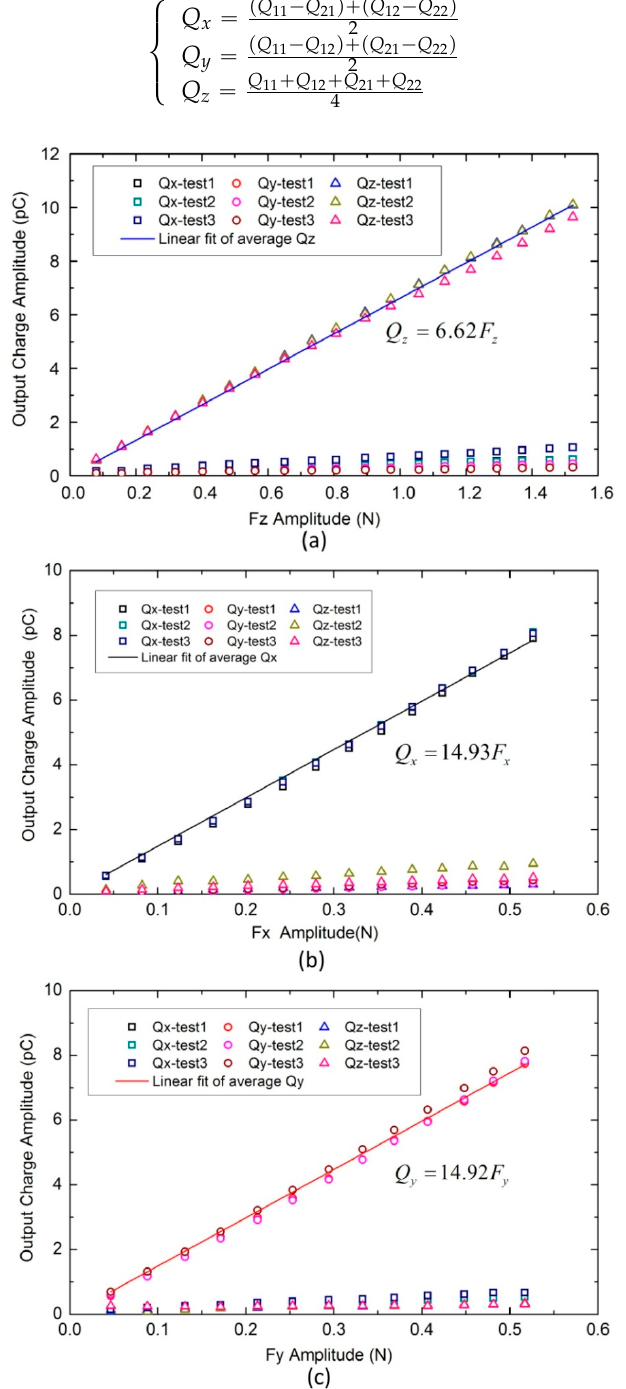
Figure 7. Average amplitudes (100 wave periods) of sinusoidal output charges versus sinusoidal input forces (20 Hz). In which symbols ‘ ˝ ’, ‘ ’, ‘ (cid:52) ’ represent combinational output charges Q x , Q y , and Q z , (cid:35) respectively. Each symbol has three colors indicating responses from three repeated tests. Solid lines represent linear fit of average response of the three repeat tests. ( a ) z-axis; ( b ) x-axis; ( c )